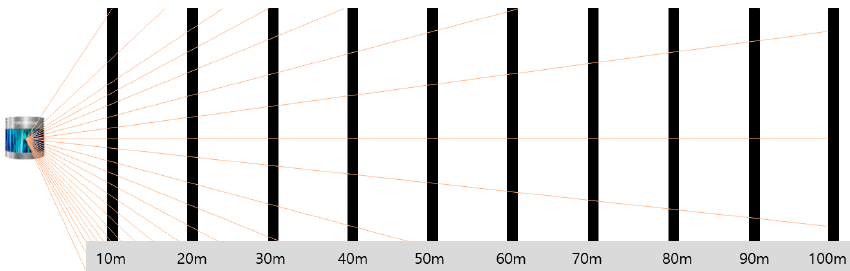
Figure 2. Side view of laser beams arriving at each distance.